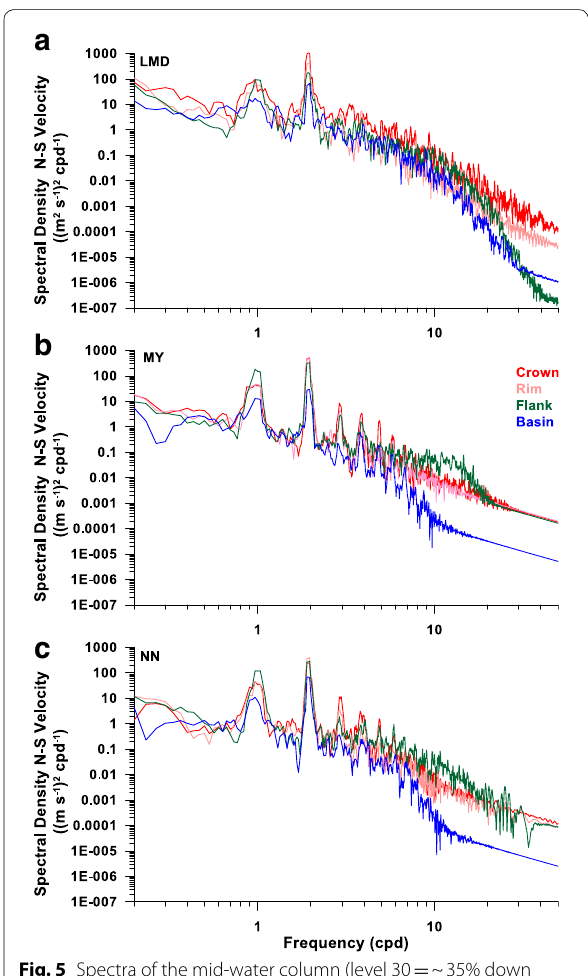
Fig. 5 Spectra of the mid-water column (level 30 the water column from the surface) North–South velocity baroclinic anomalies at four locations over the guyot: crown (C) (red), rim (R2) (pink), flank (F2) (green), and basin (B2) (blue) from simulations using the a LMD, b MY, and c NN vertical mixing parameterizations